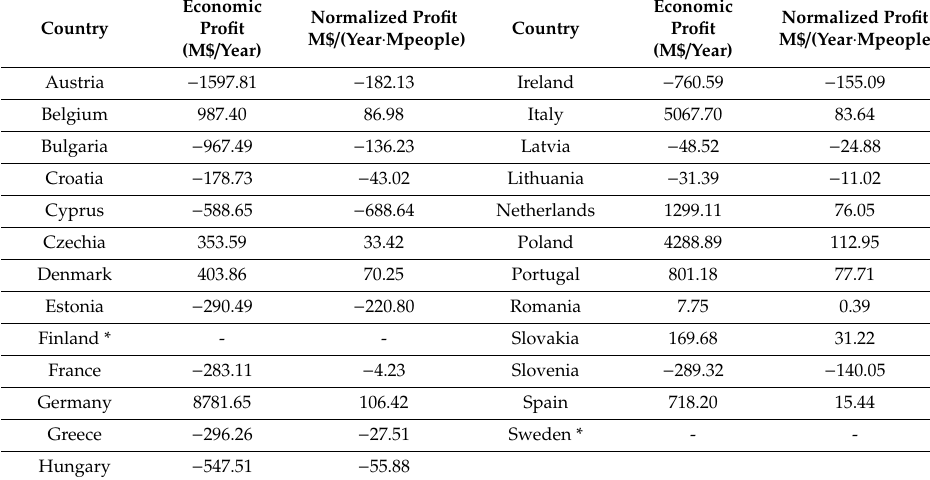
Table 4. Economic and Normalized Profit for each EU Member State from an industrial point of view when maximizing sustainability